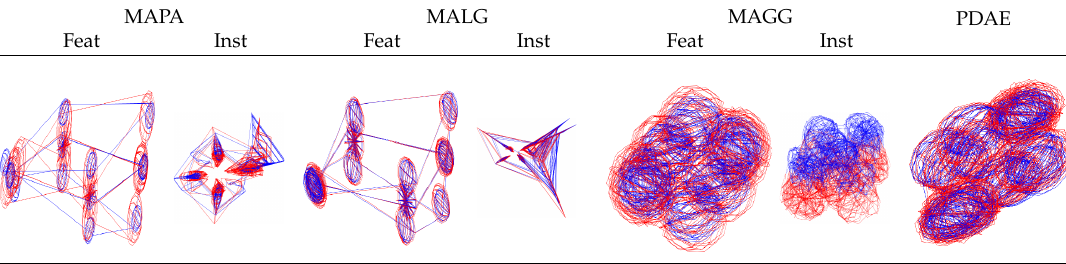
Figure 7. Alignments of 3D-3D motion manifolds: Each graph visualises a different way of aligning the manifolds underlying datasets X and Y , which are collected from snapshots of 90 ◦ steps at u 1 and 30 ◦ steps at u 2 . All manifolds of the instance-level methods collapsed or misaligned. The outcome of MAGG-feat and the deep autoencoder shows the expected results, that is six spheres representing snapshots of the pendulum movements on a 4-manifold homeomorphic to S 2 × S 2